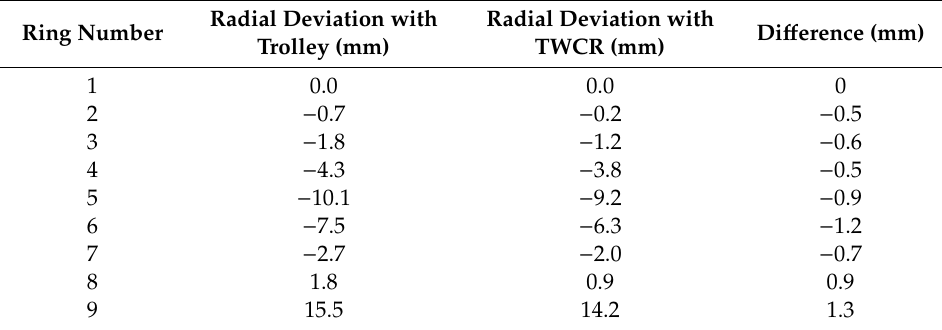
Table 6. Radial deviation with trolley and WCR